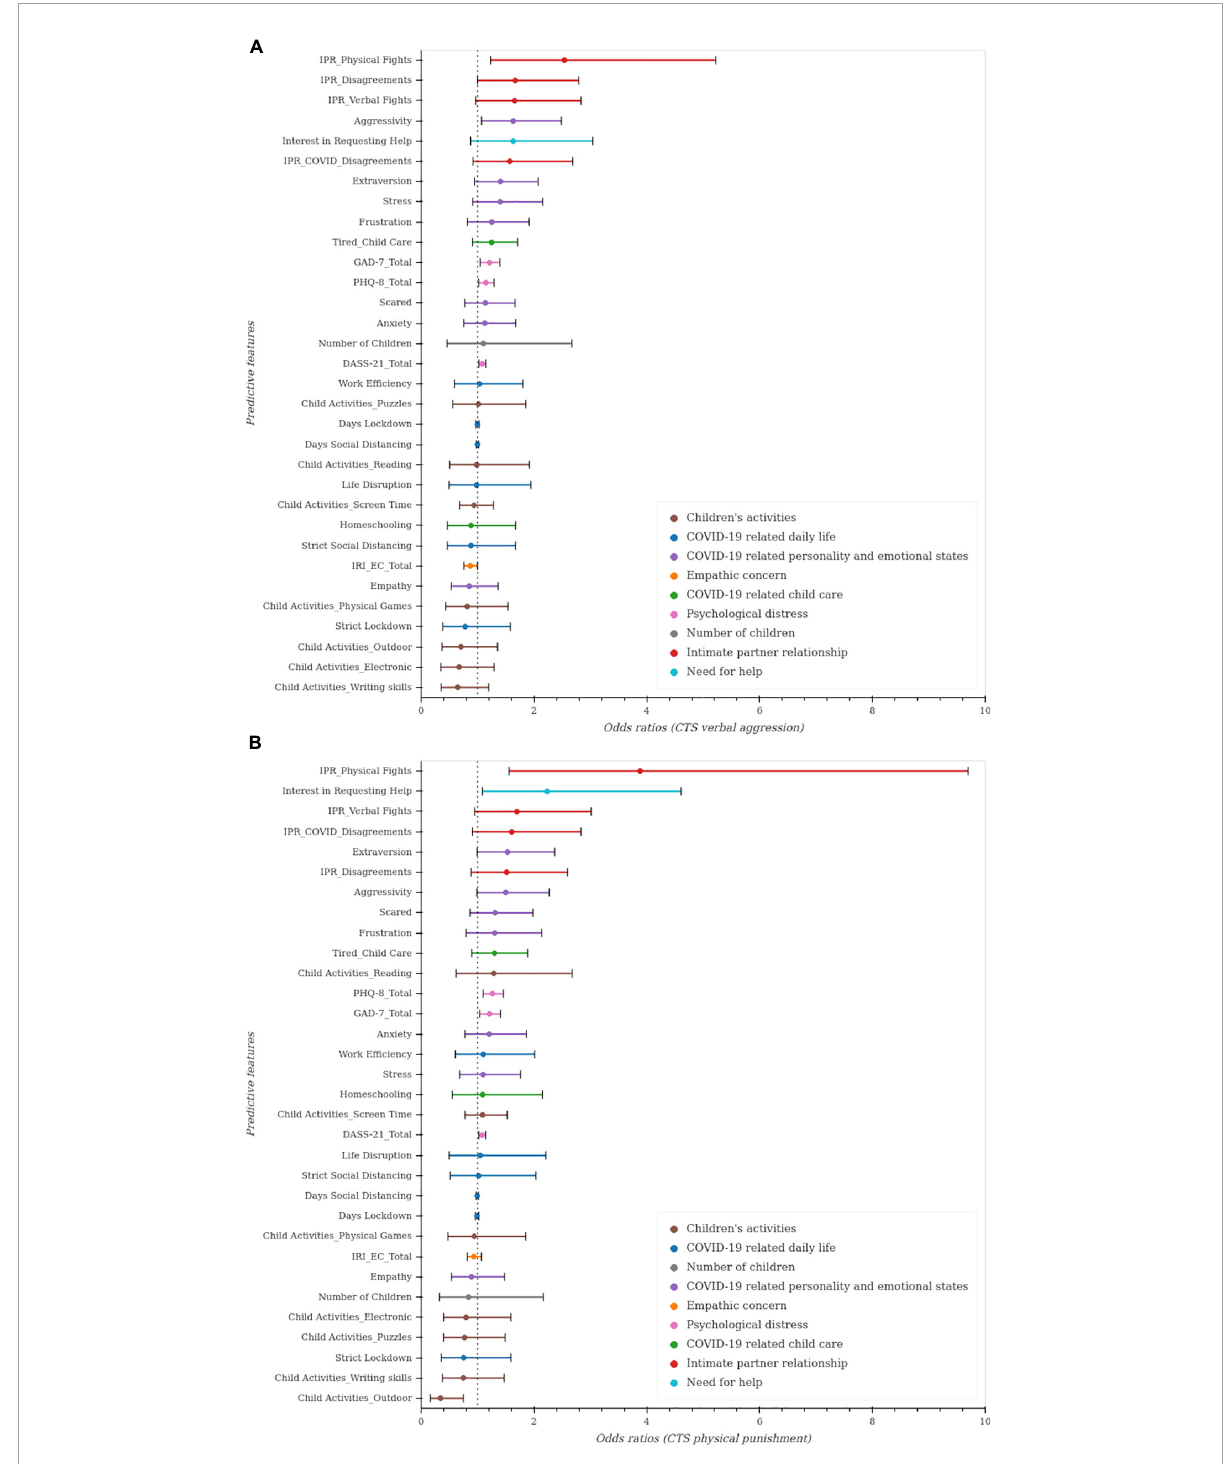
FIGURE1 Unregularized regressions to predict indicators of child maltreatment. Unregularized logistic regression was used with 32 predictive factors after adjusting for age, gender and state region. Odds ratios and 99.84% confidence intervals (CI) for each predictor. The OR point estimates are represented by the dots and the line widths for each predictor present the 1- 0.05/32% = 99.84% CI adjusted for multiple comparisons using Bonferroni (as the gold standard method for multiple comparisons). Statistical significance is indicated by CI not including 1 at the 0.05/32 level. (A) . Predictors of verbal aggression toward children. (B) . Predictors of physical punishment toward